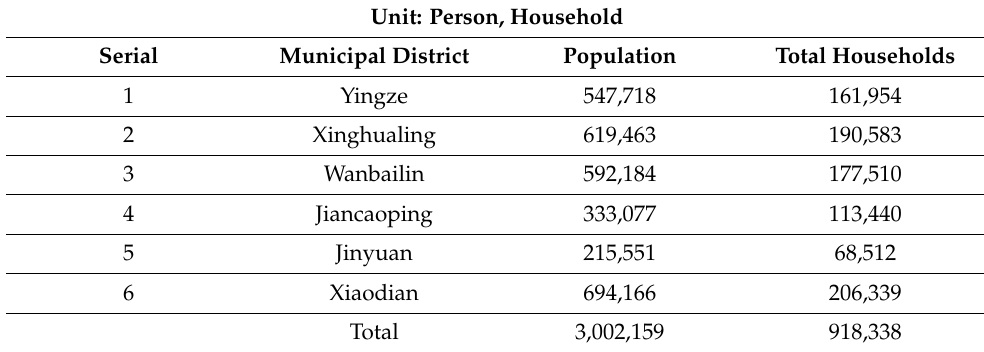
Table 1. Permanent Resident Population of